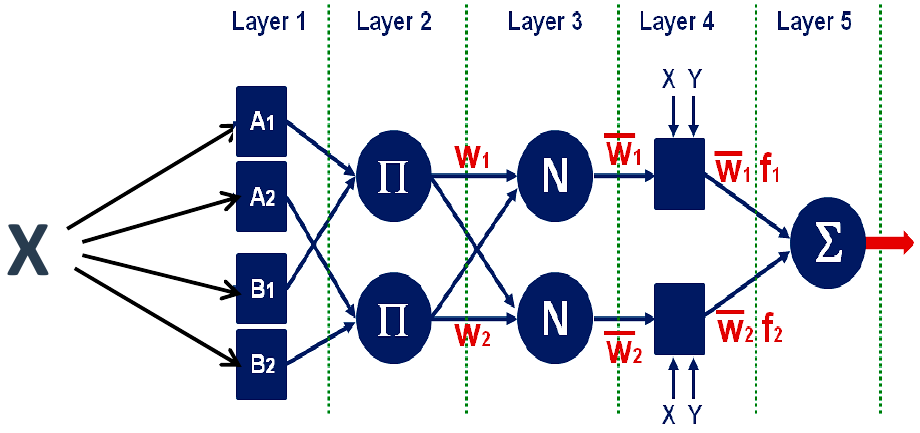
Figure 6. ANFIS structure for one input